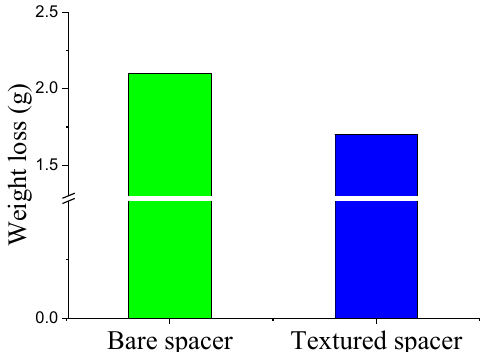
Figure 12. Weight loss of bare and textured gear washers.